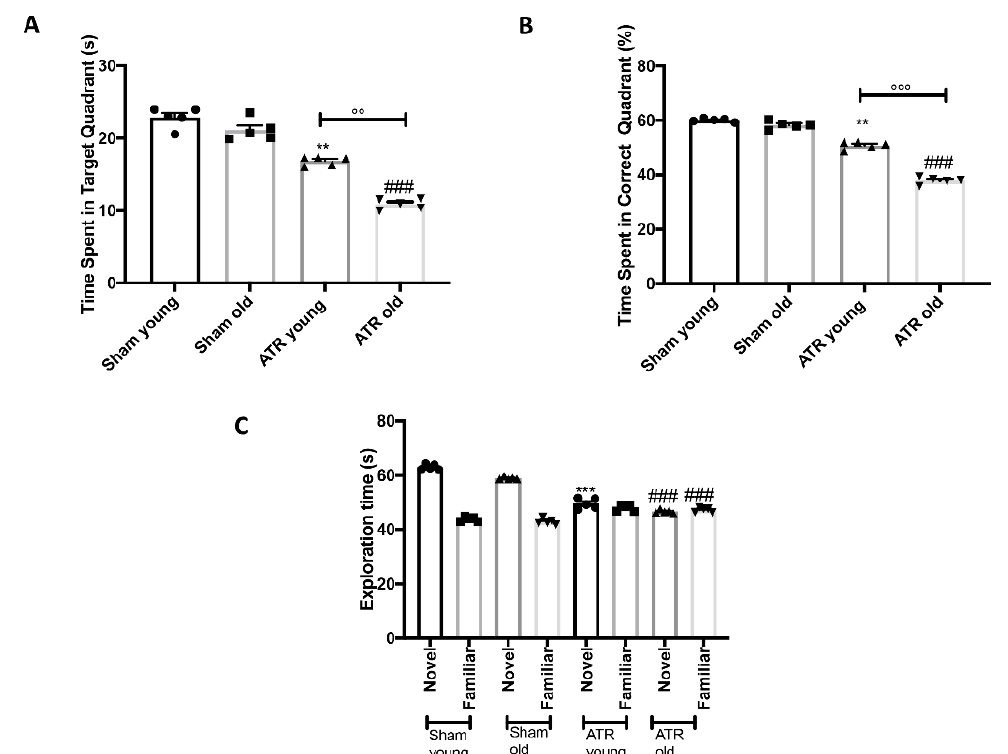
Figure 2. Effect of ATR inhalation on spatial learning and memory function. Morris Water Maze Test ( A , B ); Novel object recognition ( C ). MWM test showed that aged mice were more susceptible compared to young to develop spatial and memory deficits after ATR inhalation. No significant difference were found between young and aged mice during NOR. Data is expressed as the mean ± SEM of n = 5 animals for each group. ** p < 0.01 vs. Sham young; *** p < 0.001 vs. Sham young; ### p < 0.001 vs. Sham old; °° p < 0.01 ATR old vs. ATR young; °°° p < 0.001 ATR old vs. ATR young.